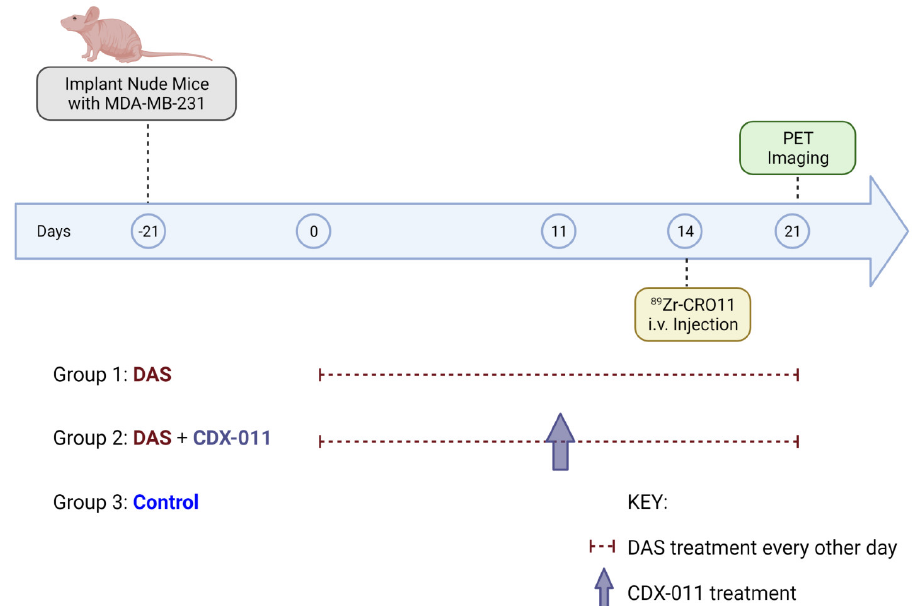
Figure 2. PET imaging and treatment paradigm in gpNMB-negative MDA-MB-231 xenografted mice. PET imaging with [ 89 Zr]ZrDFO-CR011 was performed at 21 days after treatment of dasatinib (n = 4), the combination of dasatinib and CDX-011 (n = 5), or vehicle control group (n = 4). DAS = dasatinib. Figure created with Biorender.com.